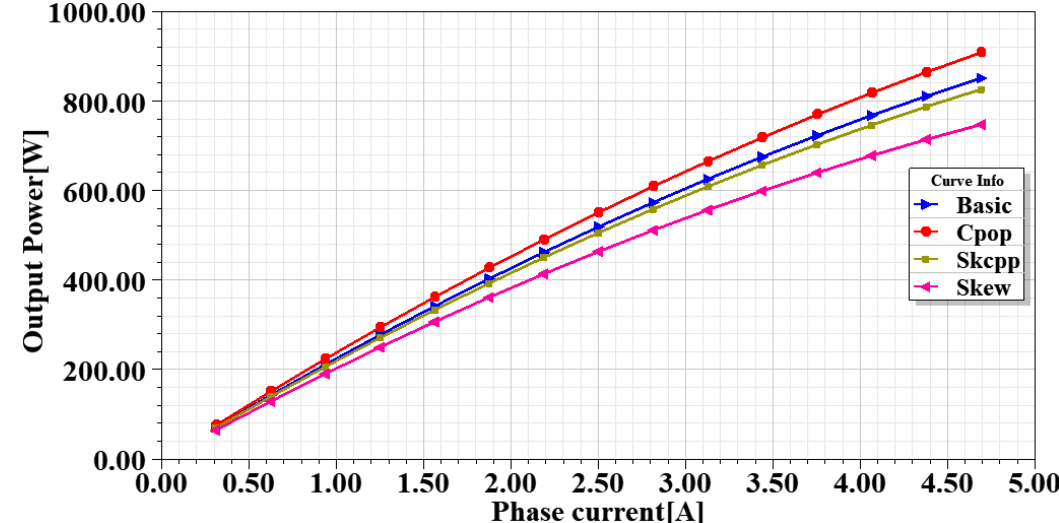
Figure 31. Output-power against phase current (rms) for each rotor designs @ 375 r/min.